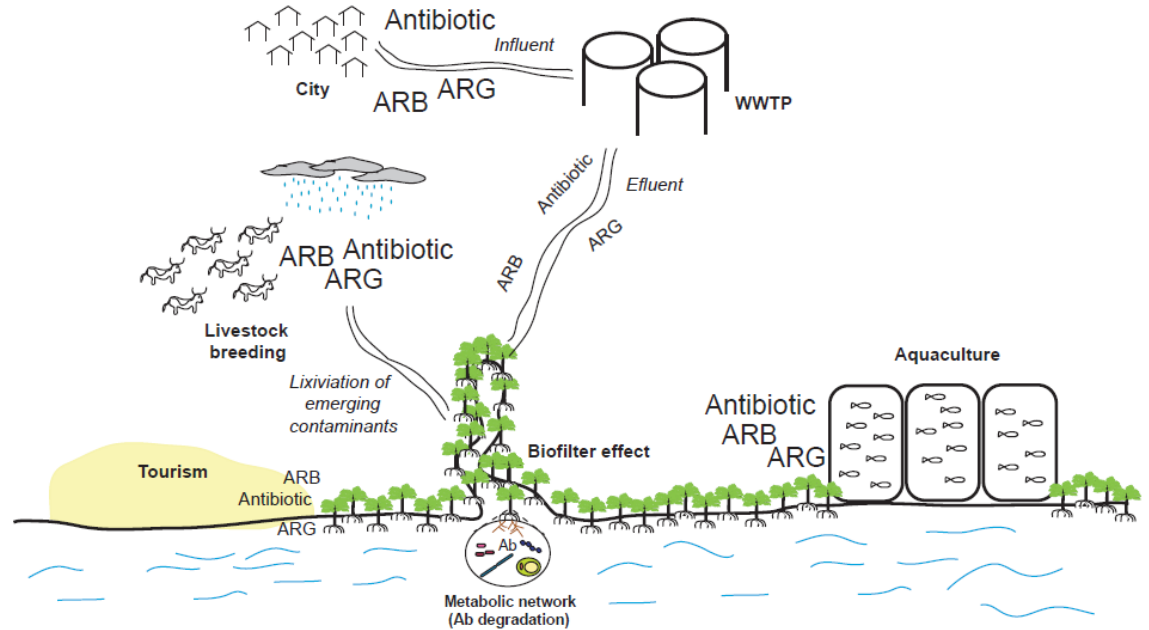
Figure 2. Anthropogenic activities that can influence the presence of emerging contaminants related to antibiotics in mangroves. Legend: Ab: Antibiotic. ARG: Antibiotic resistance gene. ARB: Antibiotic-resistant bacteria. WWTP: Wastewater treatment plant.